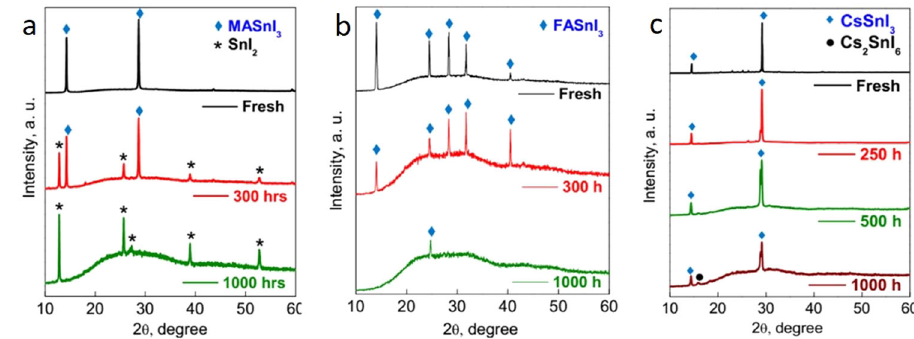
Fig. 2 Effects of temperature exposure with time on different perovskite compositions. Evolution of the structure with time followed by the XRD patterns of a MASnI 3 , b FASnI 3 , and c CsSnI 3 , after thermal annealing at ~90 °C. (Fig. 2 adapted with permission from ref. 19 , Copyright 2019